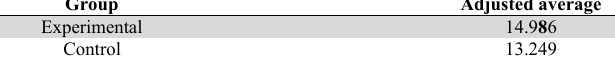
Adjusted arithmetic averages and standard errors Group Adjusted